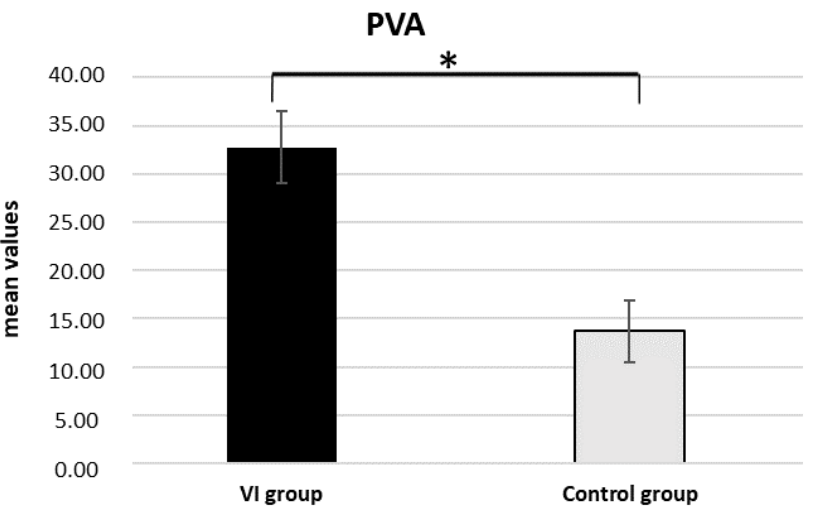
Figure 2. Autonomic result. The bar graph shows significant differences for PVA values between the VI and control group. Bars represent ±1 SE. Star (*) marks statistically significant pairwise com-